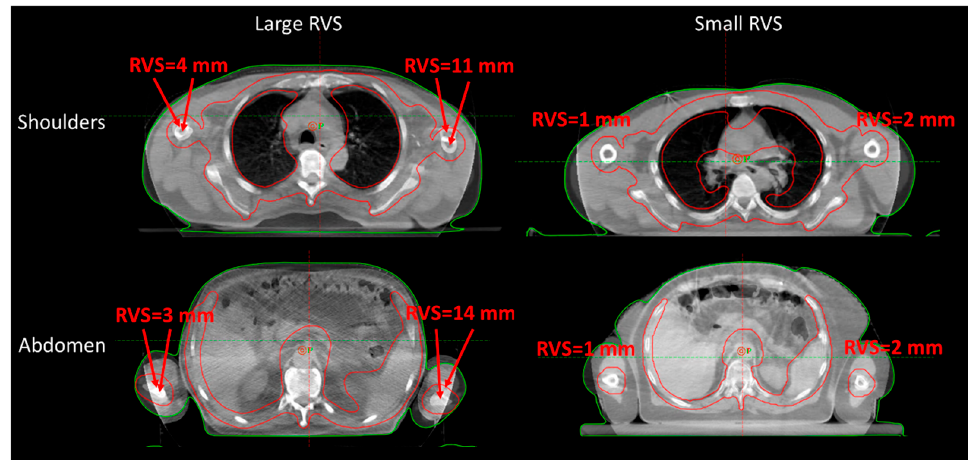
Figure 1. Representative CBCT-CT matching was performed for the shoulders ( top ) and abdomen ( bottom ) isocenters. The RVS was measured as the maximum center distance between the bone marrow of the extremities. Large ( left ) and small ( right ) RVS values are reported. RVS = residual vector shift.